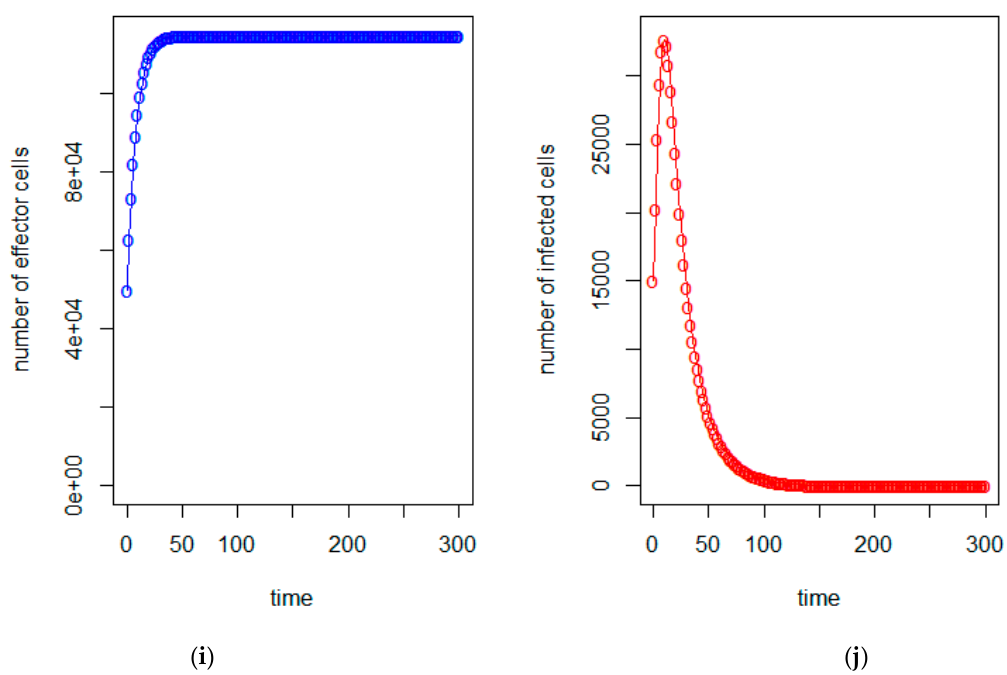
Figure 2. ( a , b ): The immune-effector cells ( a ) and virus-infected cells ( b ) vs. time (days); ( c , d ): The relationship between the immune-effector cells and virus-infected cells; ( e , f ): 3D relationships of the effector cells, immune-effector cells and unit of time (days); ( g , h ): The immune-effector cells ( g ) and virus-infected cells ( h ) vs. time (days). The same as Case 2, except I 0 = 75,000 cells; ( i , j ): The immune-effector cells ( i ) and virus-infected cells ( j ) vs. time (days). The same as Case 2, except V 0 = 15,000 cells.